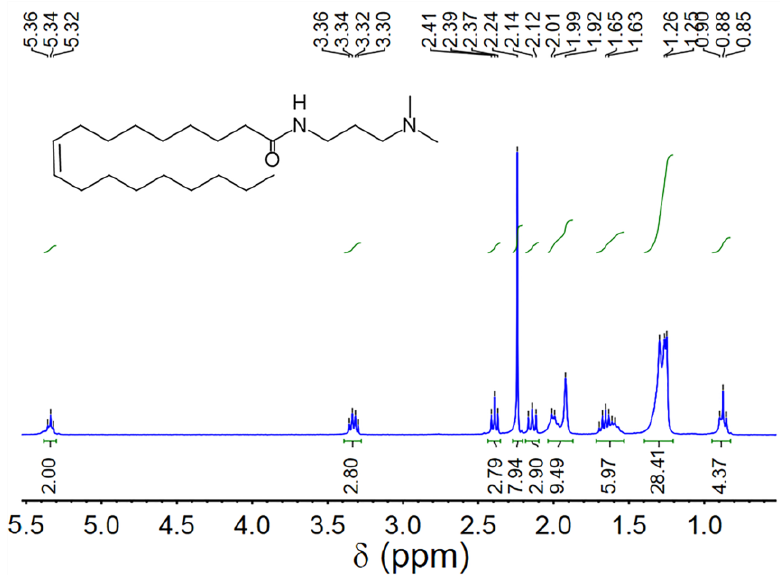
Figure 8. 1 H NMR spectrum of UC 18 AMPM (400 MHz, CDCl 3 ).